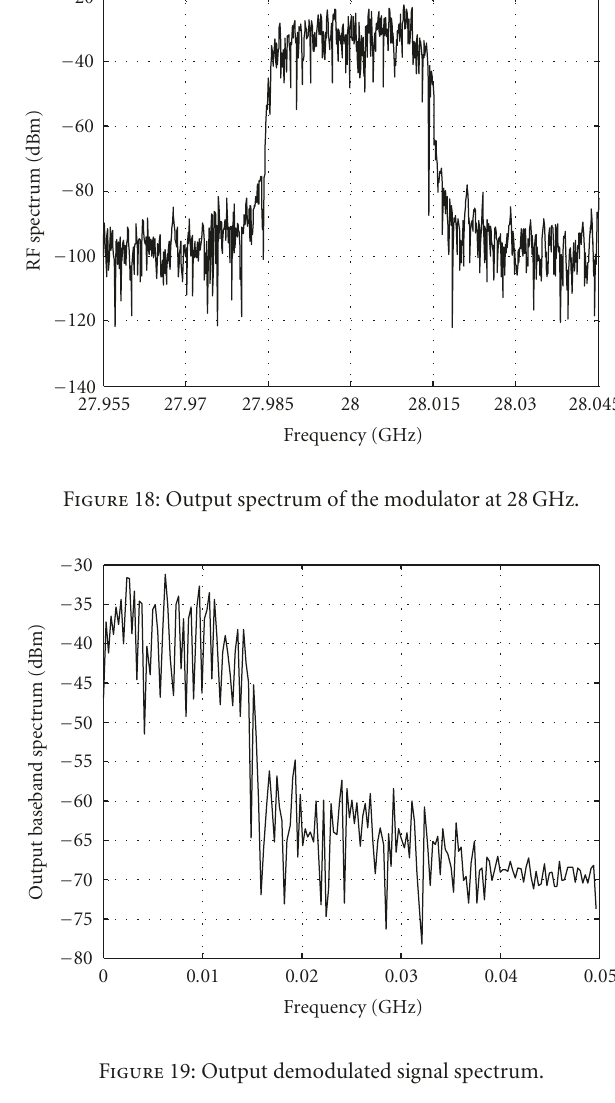
flatten the conversion loss of the system versus LO